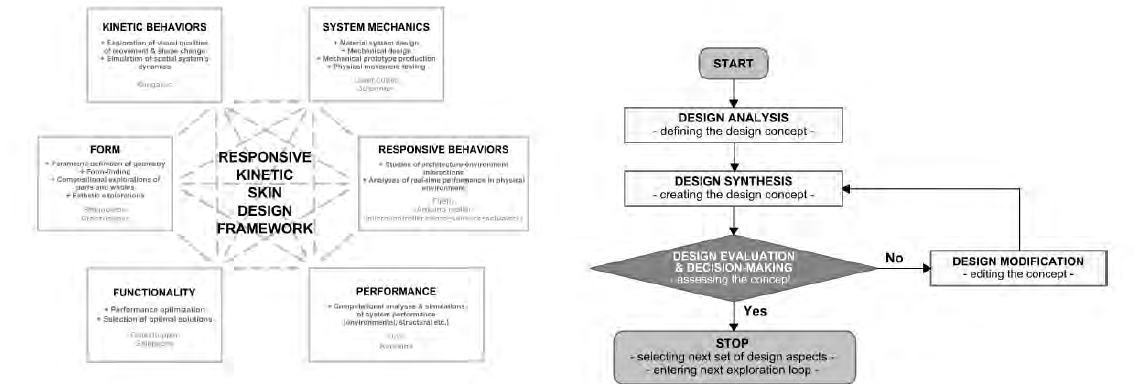
Figure 10. Responsive kinetic skin design framework and its cycle (source: Zboinska et al., 2015)